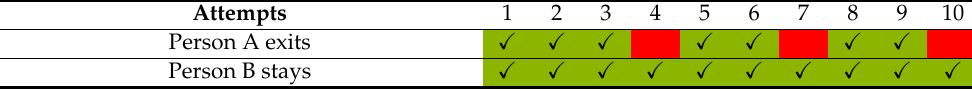
Table 10. New algorithm testing two users; one exits, and one stays, table of results.